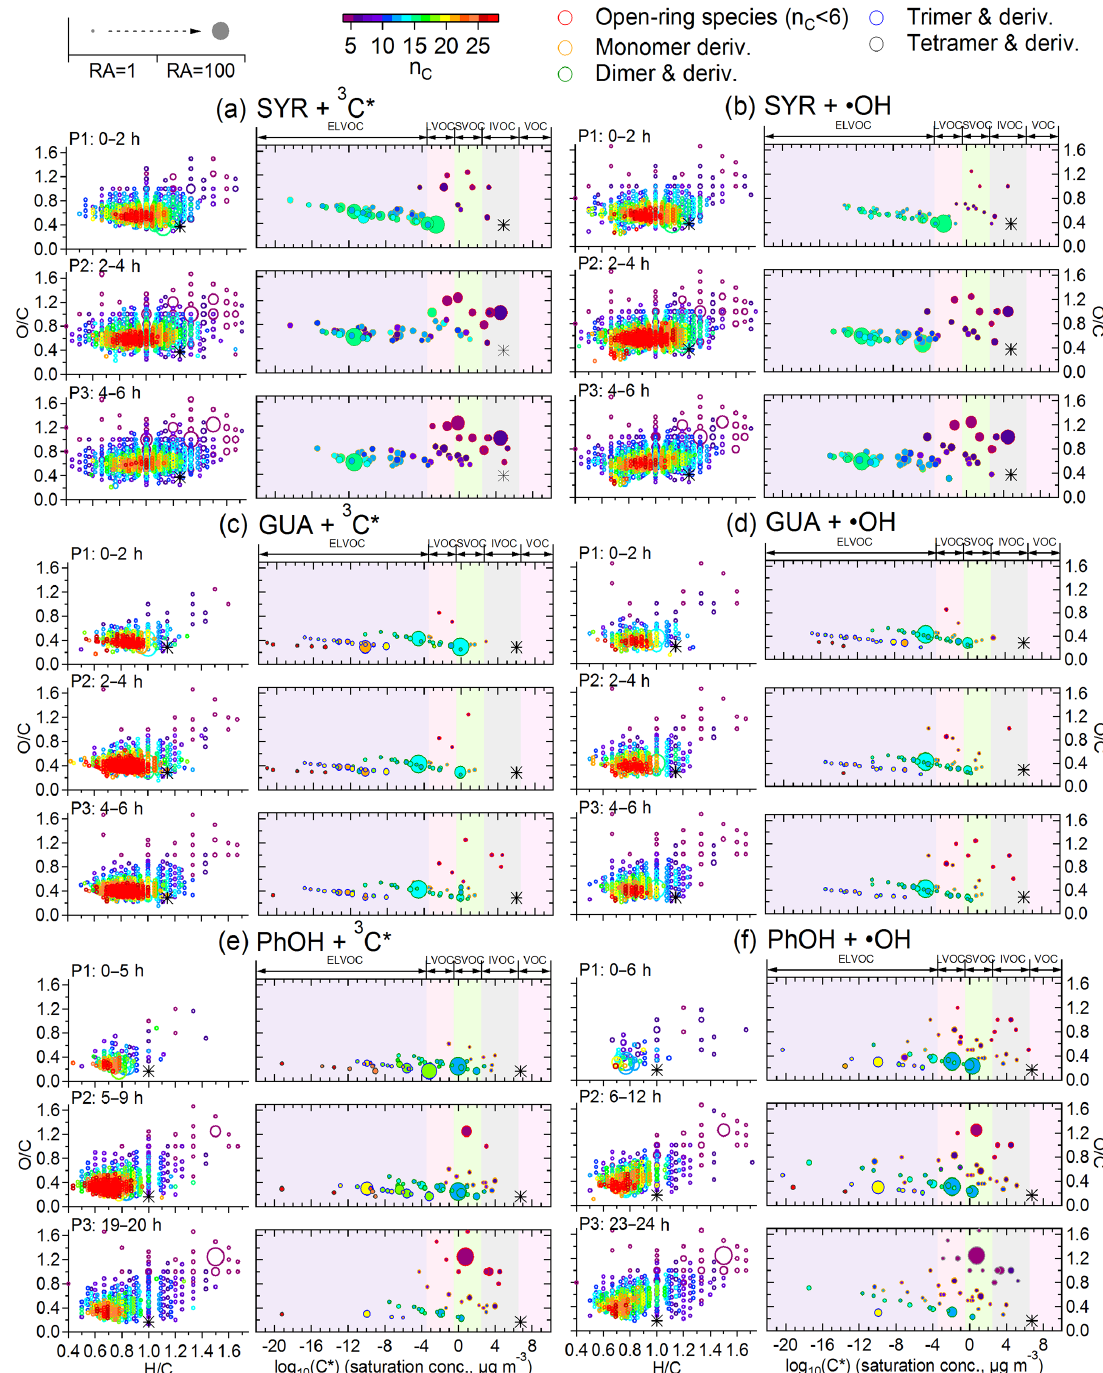
Figure 5. O / C and H / C of SYR, GUA, and PhOH aqSOA molecules formed during three different stages of the 3 C ∗ - and • OH-mediated reactions. To the right of each O / C vs. H / C plot is a plot that shows the O / C and volatility (log 10 C ∗ in µgm − 3 ) for the 50 most abundant aqSOA molecules. On the O / C vs. C ∗ plots, the volatility ranges are indicated by colored bands: (1) extremely low-volatile organic com- pounds (ELVOC; C ∗ <3 . 2 × 10 − 4 µgm − 3 ), (2) low-volatility organic compounds (LVOC; 3 . 2 × 10 − 4 µgm − 3 < C ∗ <0.32µgm − 3 ), (3) semi- volatile organic compounds (SVOC; 0.32µgm − 3 < C ∗ <320µgm − 3 ), (4) IVOC (320µgm − 3 < C ∗ <3 . 2 × 10 6 µgm − 3 ), and (5) volatile or- ganic compounds (VOC; C ∗ >3 . 2 × 10 6 µgm − 3 ). On the O / C vs. C ∗ plots, the degree of oligomerization for each species is represented by the stroke color. On both O / C vs. H / C and O / C vs. C ∗ plots, sizes of points are scaled by the relative abundance (RA) and colored by the number of carbon atoms ( n C ). The black stars represent phenolic